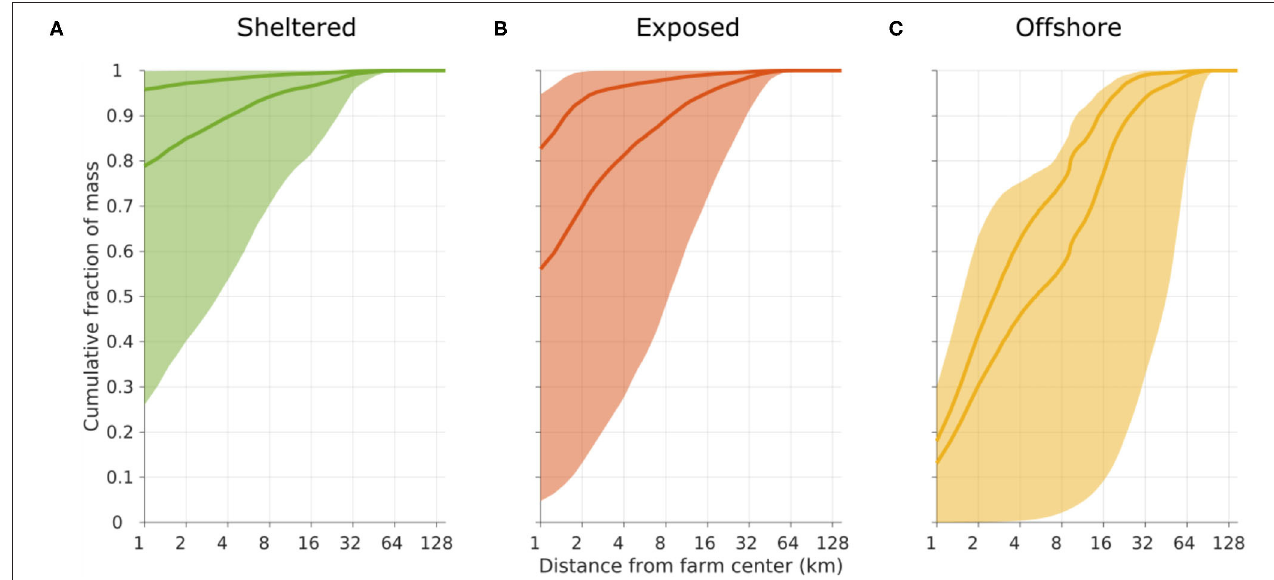
FIGURE 4 | Cumulative frequency plot of the transport distance of POM before sedimentation on the seafloor, released from the sheltered [ (A) , green], exposed [ (B) , red], and offshore [ (C) , yellow] sites. The shaded regions indicate the span from considering only the slowest sinking D 1 (lower limit) to considering only the fastest sinking D 4 (upper limit) compartments. The darker curves represent scenarios A (lower curve) and B (upper curve); cf. Figure 3 .